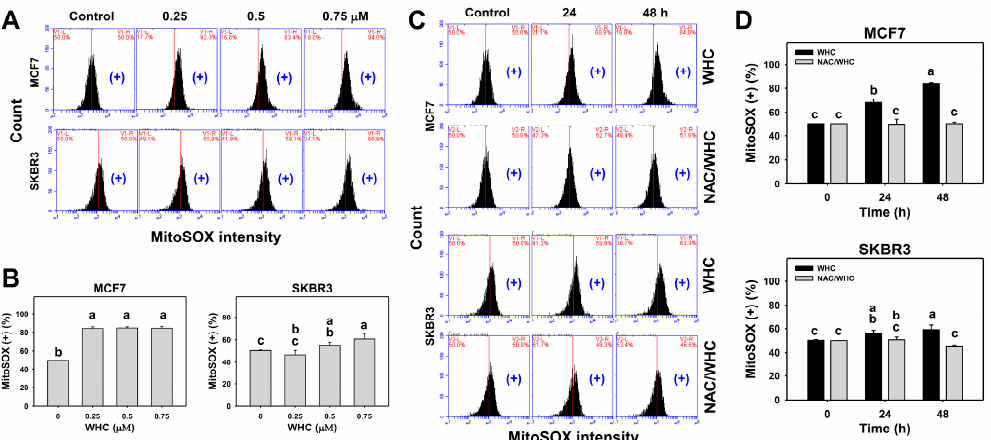
Figure 5. WHC differentially induces MitoSOX generation of breast cancer cells. ( A , B ) MitoSOX profiles and statistics for dose effects on WHC. Breast cancer MCF7 and SKBR3 cells and normal breast (M10) cells were treated with WHC (control (0.075% DMSO), 0.25, 0.5, and 0.75 μ M) for 48 h. (+) located on the right side of each profile was counted for MitoSOX (+) (%). ( C , D ) NAC pretreatments reversed the WHC-induced MitoSOX generation. Following pretreatments with NAC (10 mM for 1 h), cells were treated with the control (0.075% DMSO) and 0.75 μ M of WHC for 0, 24, and 48 h, i.e., NAC/WHC. Data are means ± SDs ( n = 3). Results marked without overlapping letters show significant differences ( P < 0.05 to 0.01).